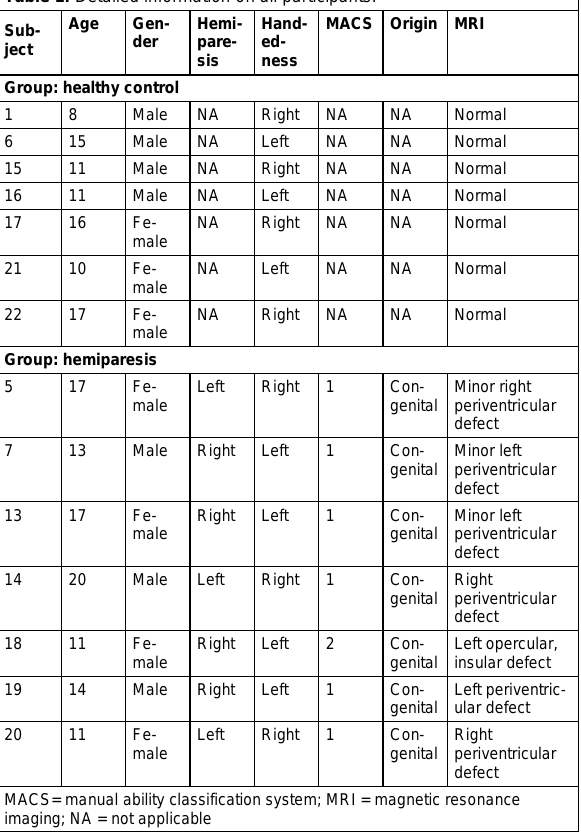
Functional magnetic resonance imaging